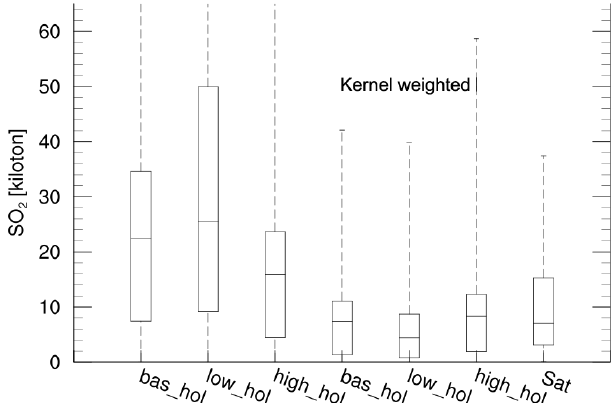
Figure 3. Distribution of daily SO 2 mass burden values in the area where satellite-derived SO 2 exceeds 0.4DU (# 61; values from Fig. 2) as box-and-whisker plots; shown for the model simulations are original data (3 left boxes) and kernel-weighted data (3 follow- ing boxes) and the satellite data. The boxes shown represent the 25th percentile, the median, and the 75th percentile values, lower whiskers the minimum value and upper whiskers the maximum